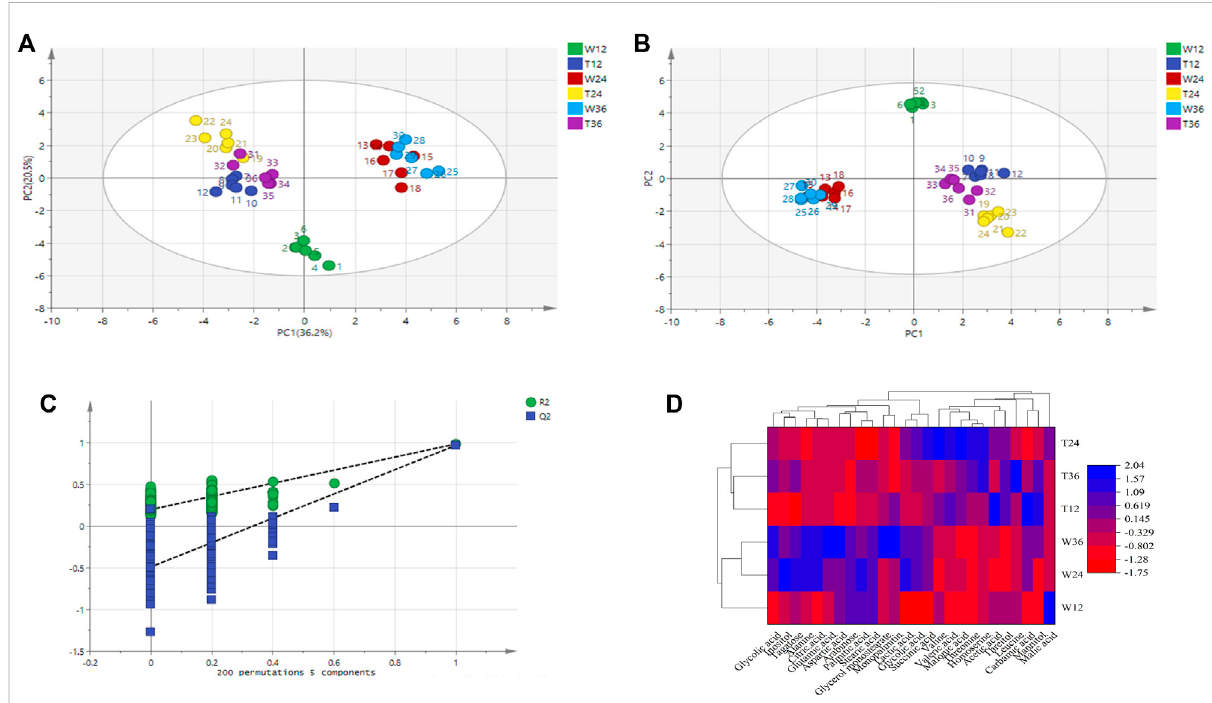
FIGURE 4 Metabolite difference in strain TWF001 and W3110. (A) Score plot of metabolite principal component analysis. (B) OPLS-DA score plot of metabolite principal component analysis. (C) OPLS-DA displacement test plot. (D) Clusteranalysisof thetwo strains. Red represents thezone of low concentration of differential metabolites and blue represents the zone of high concentration of differential